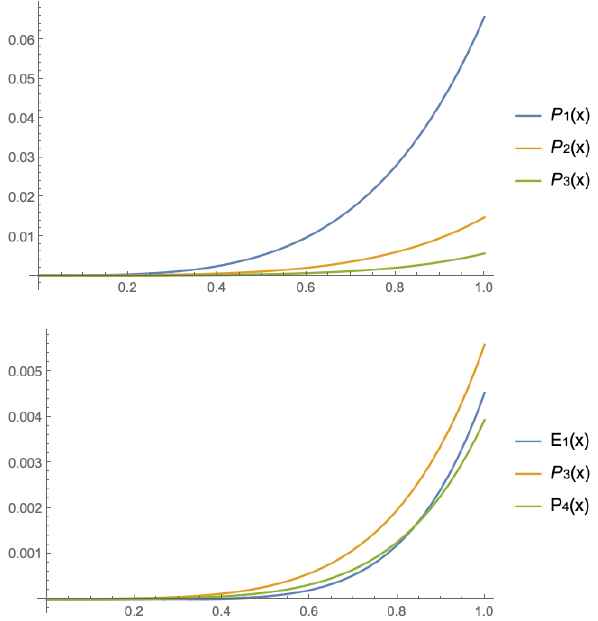
Figure 3. On the left, errors committed by the first three iterates of Picard’s method (27). On the right, comparison among E 1 ( x ) , P 3 ( x ) , and P 4 ( x )